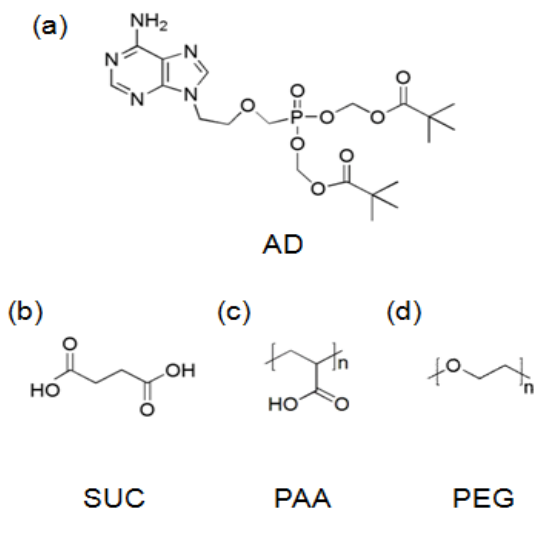
Figure 1. Chemical structures: ( a ) adefovir dipivoxil (AD); ( b ) succinic acid (SUC); ( c ) poly(acrylic acid) (PAA); ( d ) poly(ethylene glycol)